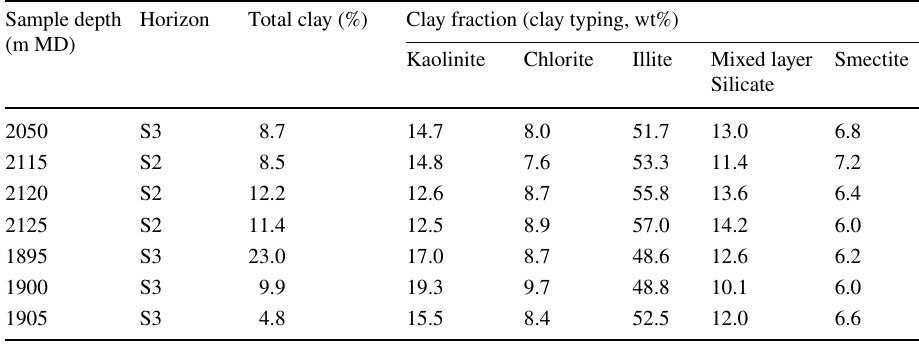
Table 4 Clay fraction of selected samples from XRD study